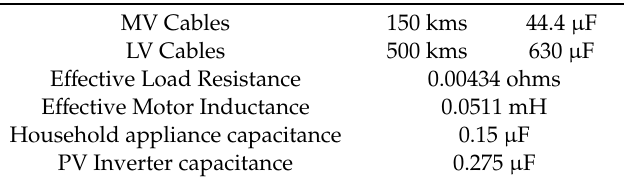
Table 2. Load and Network Component